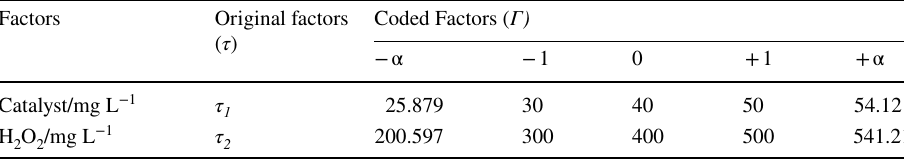
*α = 1.4121; Coded factor = (original factor – its 0